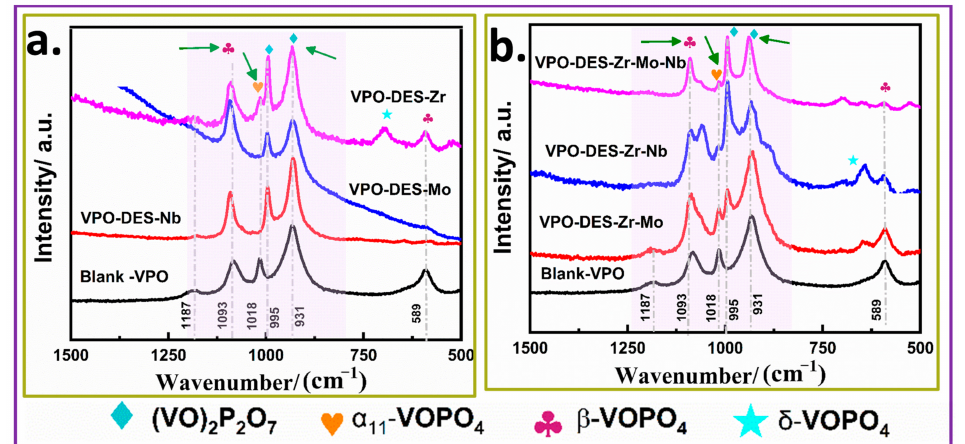
Figure 8. Raman spectra of mono- ( a ), and bi- and tri-metallic catalysts (VPO) ( b ) to explore the reactive phases in the catalysts, especially (VO) 2 P 2 O 7 and β -VOPO 4